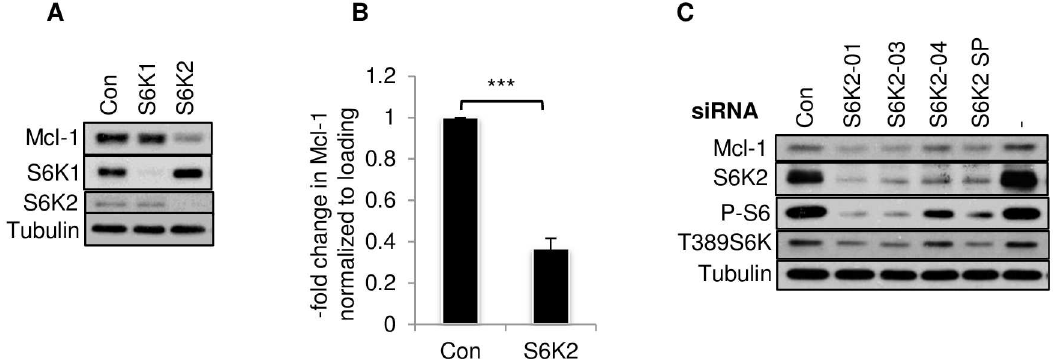
Fig 2. Knockdown of S6K2 decreasedMcl-1. T47D cells were transfected with indicatedsiRNAs as describedunder “Materials and Methods.” (A). Western blot analysiswas performed with indicatedantibodies. Tubulin was used as a loadingcontrol. (B). The intensity of Mcl-1 followingtransfectionwith SMARTpool(SP)-S6K2 siRNA, which is a combination of four individualsiRNAs, was determinedusing ImageJ. Each bar represents mean ± S.E. of 8 independent experiments. *** , p < 0.0001 using pairedStudent’s t test. (C). T47D cells were transfected with or without indicated individual or SP siRNAs. Western blot analysiswas performed with indicatedantibodies. The results are representative of at least 3